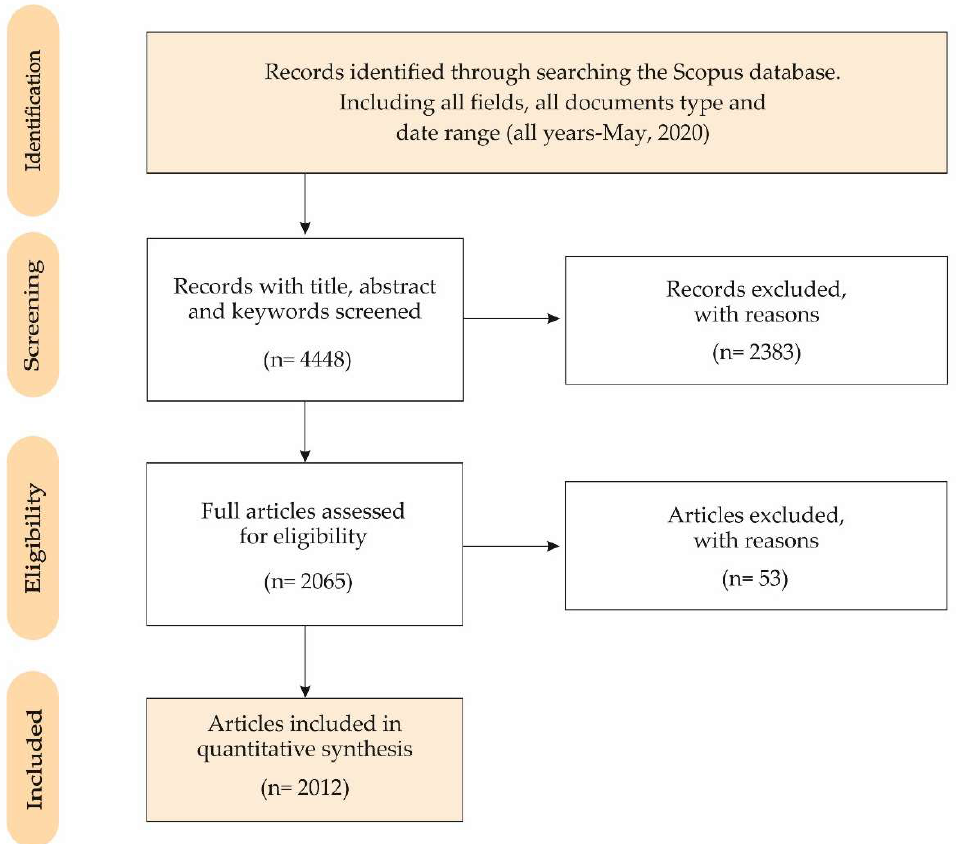
Figure 1. Document selection flowchart (PRISMA).